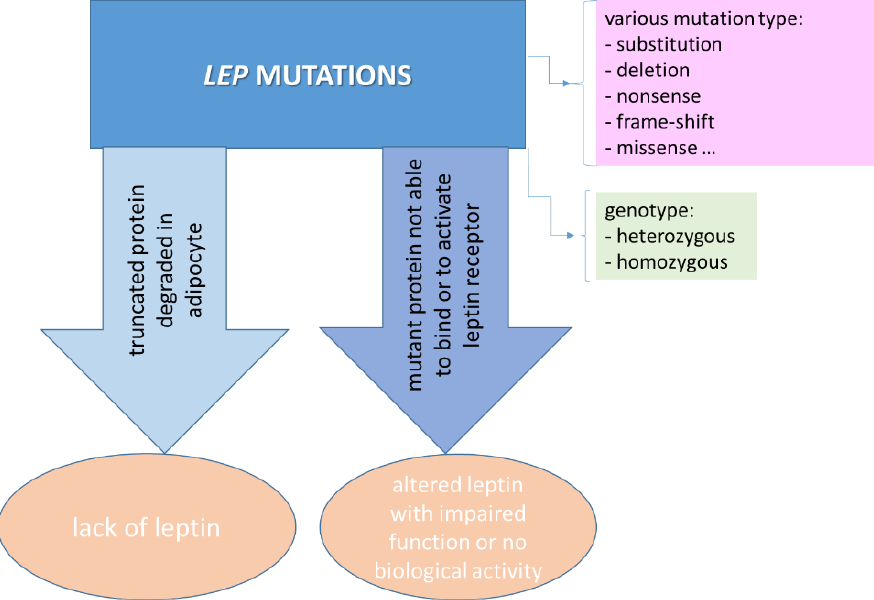
Figure 5. Effect of LEP mutations on leptin expression in obesity and CRC. The inconsistent results of mutation screening in LEP may be due to the small number of studies performed across countries with a small number of cases. Thus, prevention screening strategies with larger assessments on healthy humans are required, along with complex association studies. Moreover, LEP and LEPR have shown main effects in CRC, with increased proliferation and metastasis [68], whereas decreases in metastasis